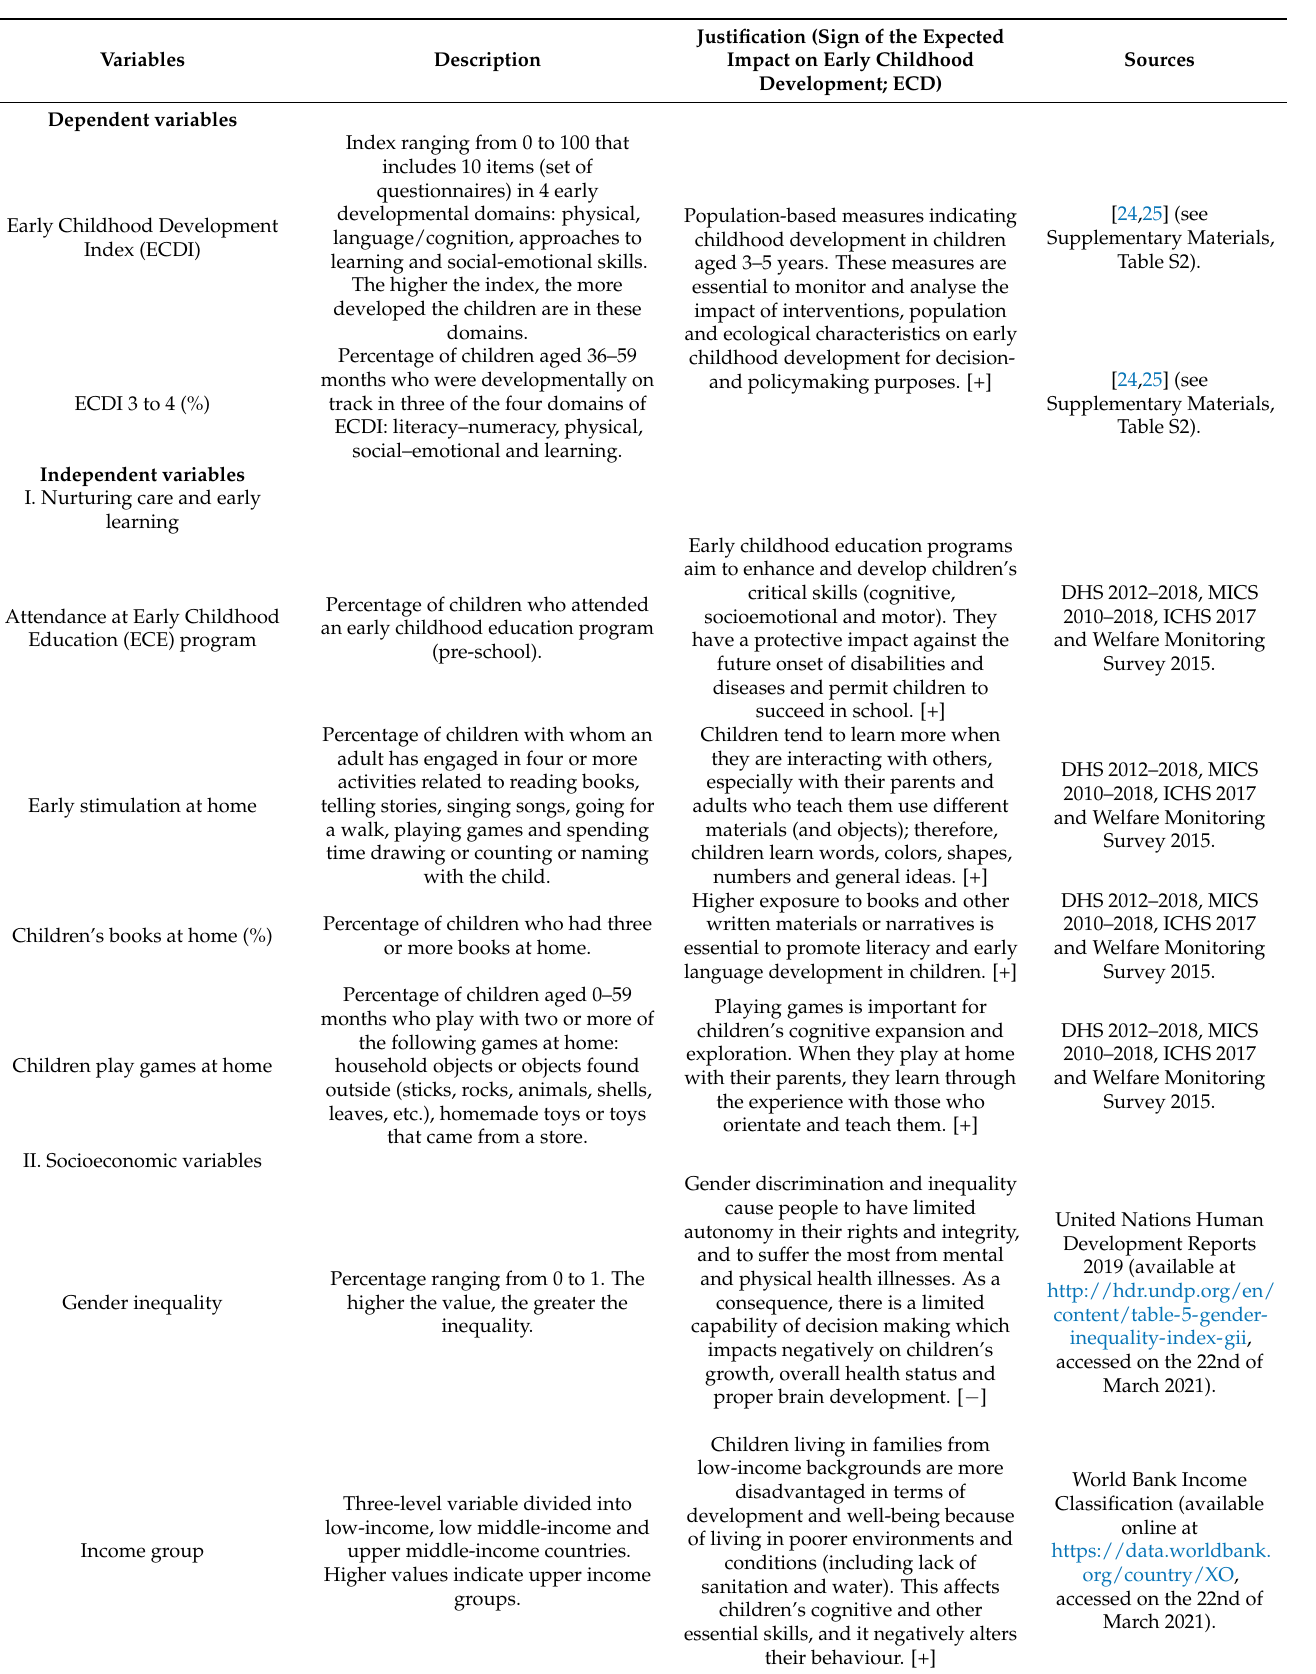
Table 1. Dependent and independent